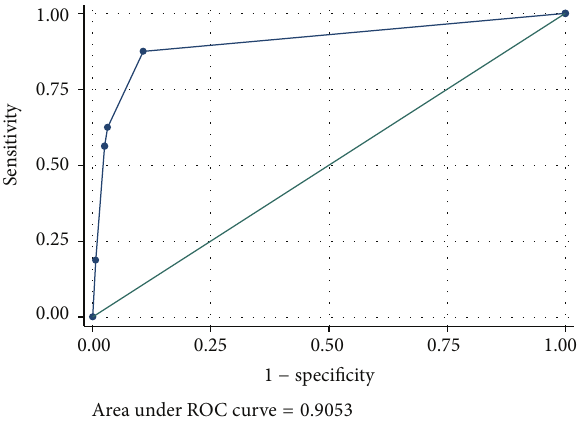
Figure 2: ROC curve for SSORTT